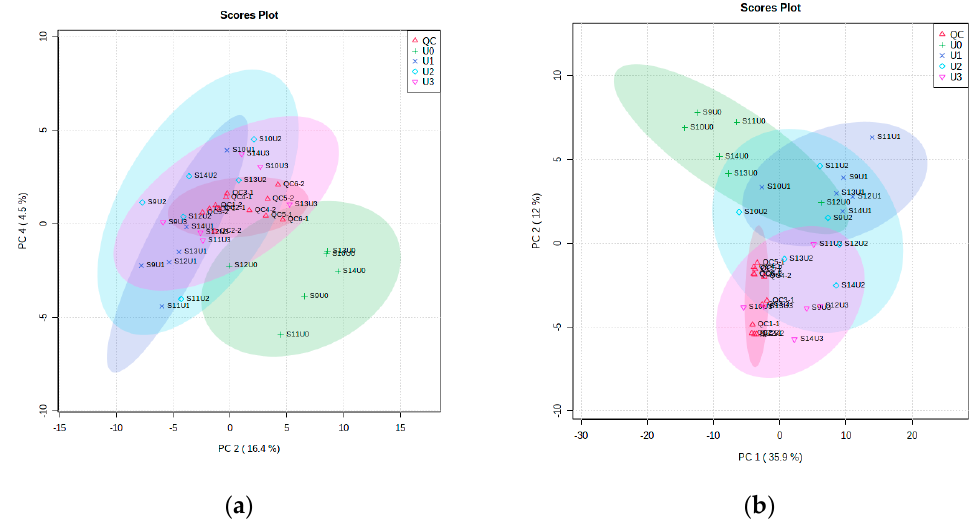
Figure 5. Principal component analyses (PCA) for time-points difference for features for metformin 1000-mg urine in positive mode ( a ) and negative mode in ( b ), n = 6.